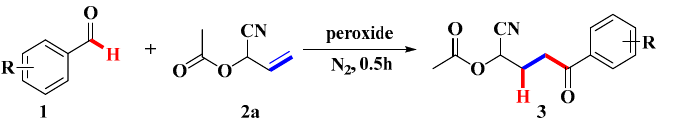
Table 1. Effects of reaction conditions on the yields of compound 3a a .